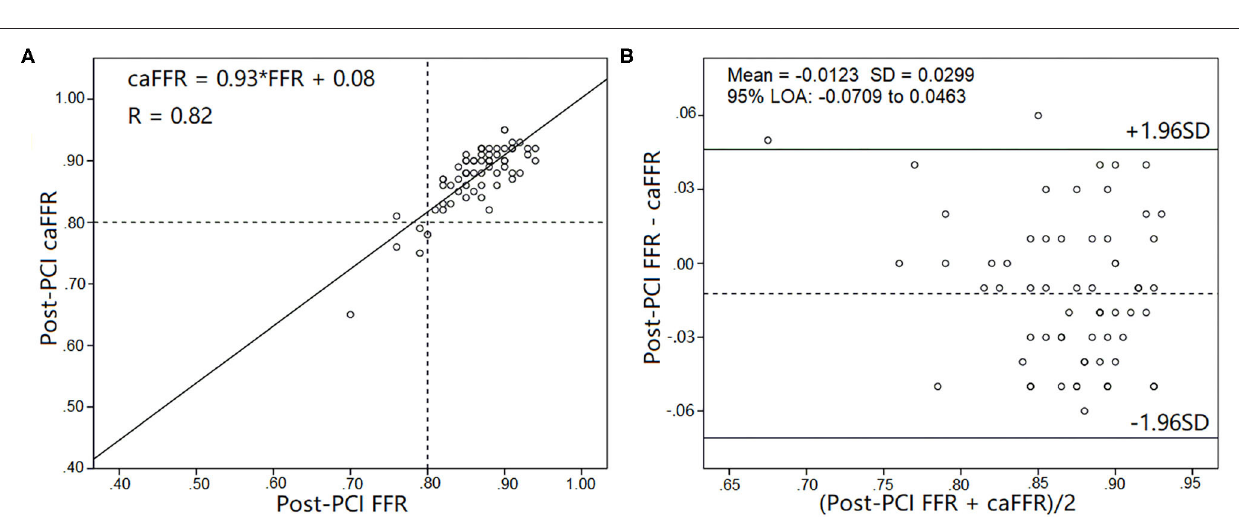
group (1.48 ± 0.55 vs. 1.0; 30.52 ± 10.51 vs. 19.50 ± 2.66; p < 0.01; Table 2